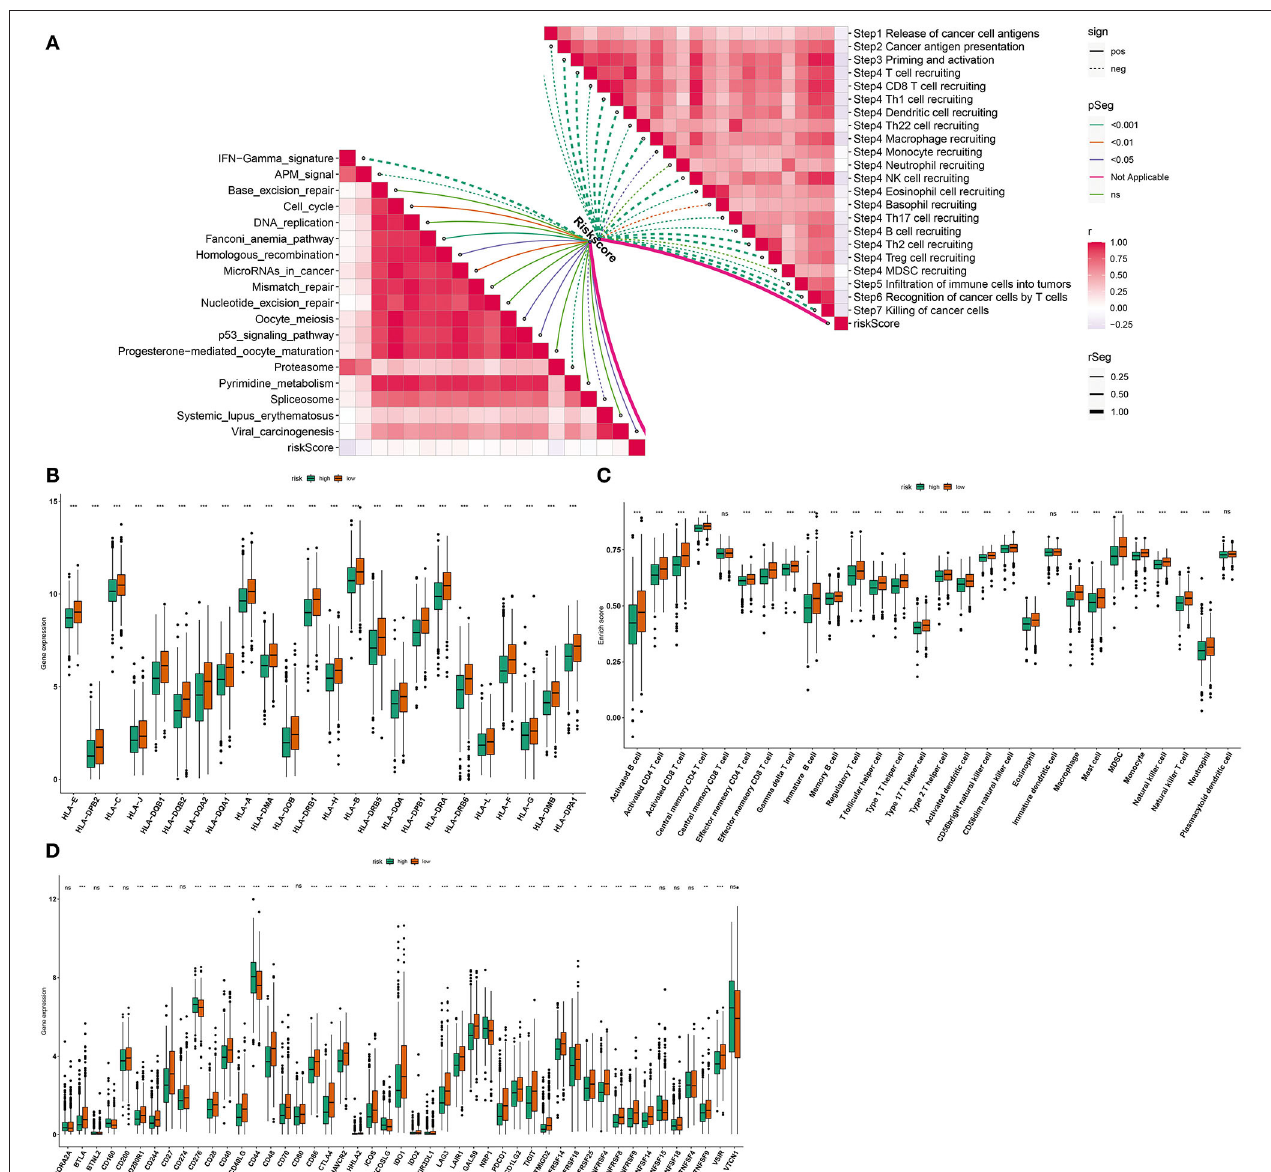
FIGURE 6 | Associations between the pyroptosis-related gene signature and immunogenicity of breast cancer. (A) Correlations between risk score and cancer immunity cycle and pathways. Dotted line indicates negative correlation and solid line indicates positive correlation. The darker the color, the stronger the correlation. (B) Box plots were plotted for HLA expression in high- and low-risk samples. (C) Box plots were depicted to show infiltration levels of immune cells in high- and low-risk samples. (D) Box plots were utilized for visualizing expression of immune checkpoints in high- and low-risk samples. Ns: not significant; * p < 0.05; ** p < 0.01; *** p < 0.001 that were derived from adjusted p